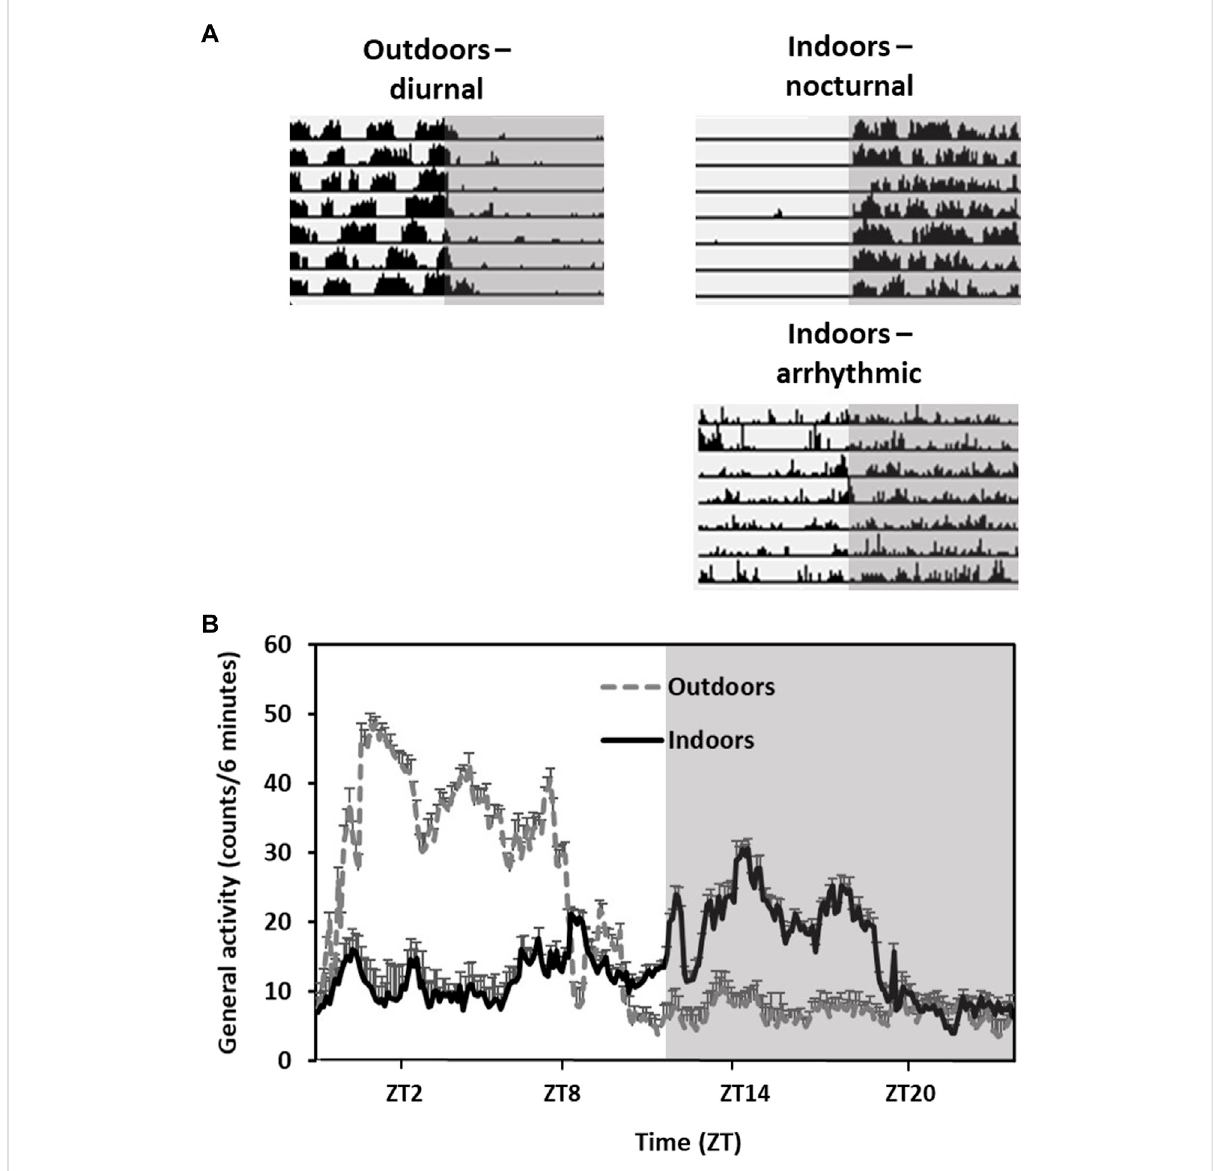
FIGURE 2 Activity rhythms of fat sand rats kept outdoors vs. indoors in the same laboratory cages. Grey background represents dark hours. (A) Representative daily actograms of an animal kept outdoors (diurnal) and two animals kept indoors (nocturnal and arhythmic). Each row represents 1 day. Days are depicted one below the other. (B) Activity rhythm: Data are the mean ± SEM of daily activity arrhythmic of animals kept outdoors or indoors. Note the diurnal activity and high amplitude in the animals kept outdoors compared with the animals held